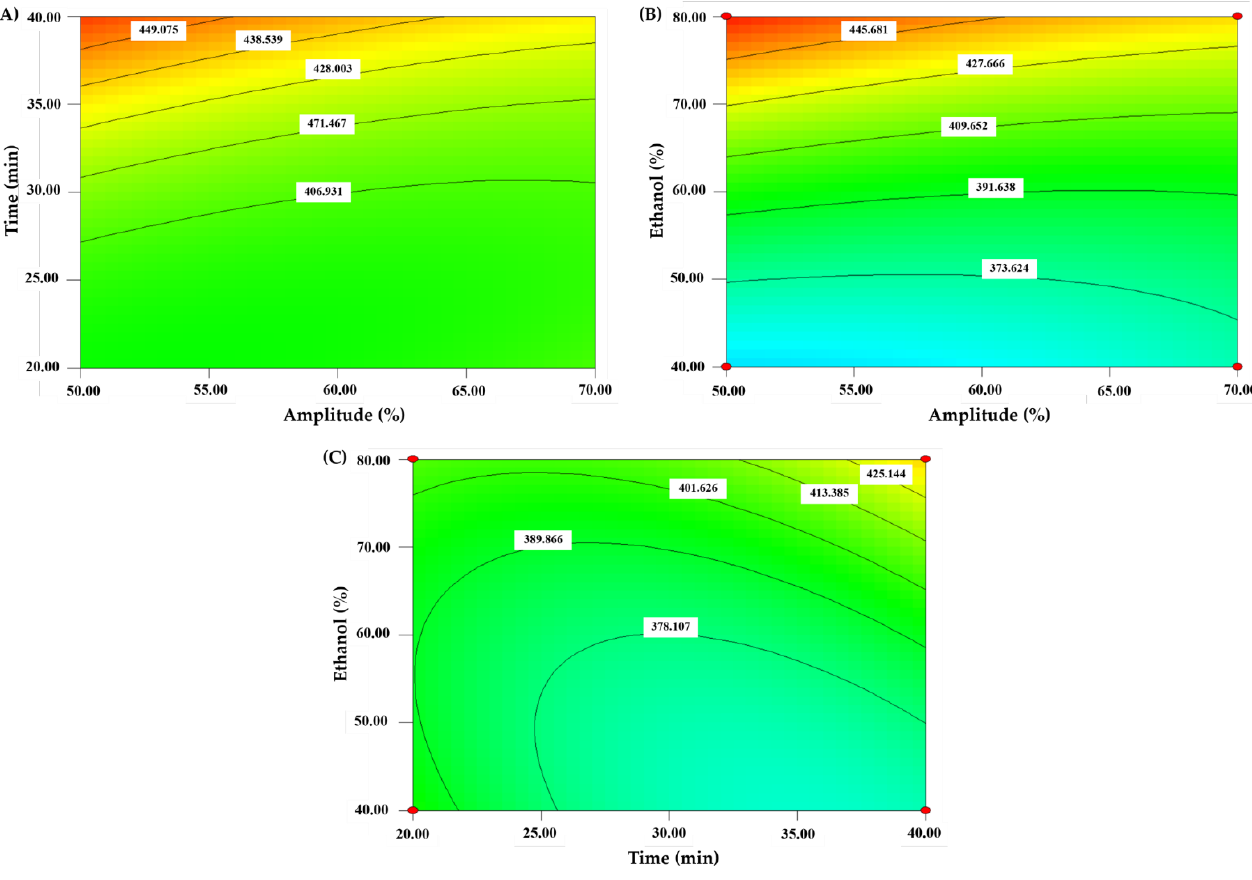
Figure 2. The contour plots of TPC from CLE extraction as influenced by the chosen independent factors. ( A ) time and amplitude; ( B ) ethanol and amplitude; ( C ) ethanol and